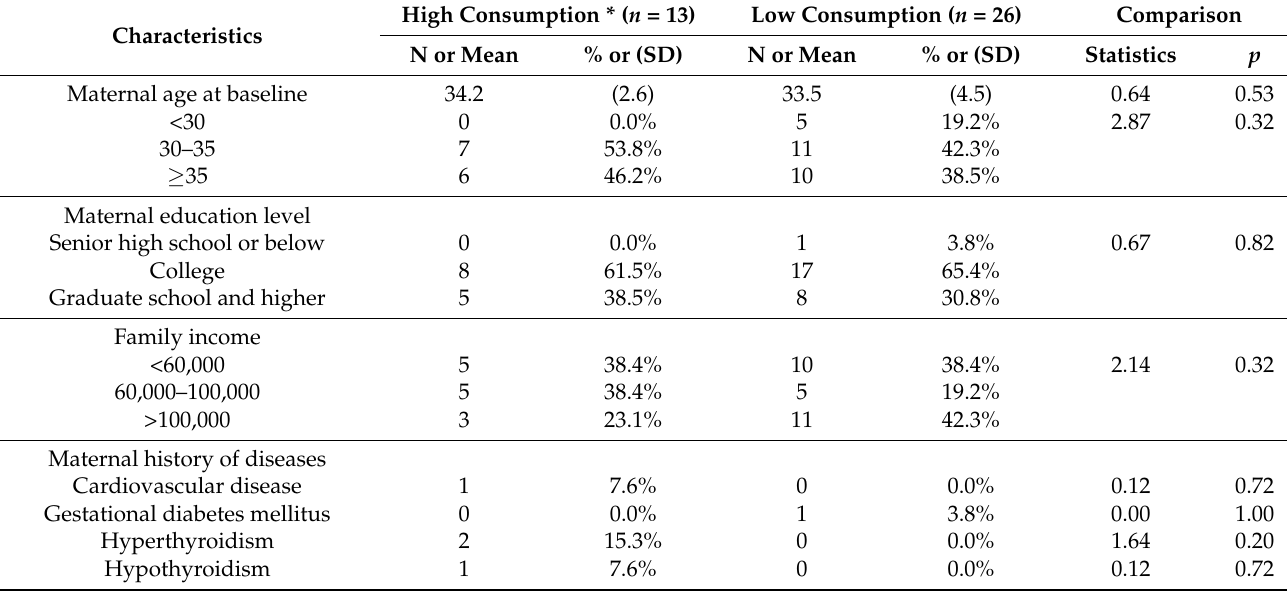
Table 1. Characteristics of groups with high and low maternal consumption of fruits and vegetables during pregnancy.